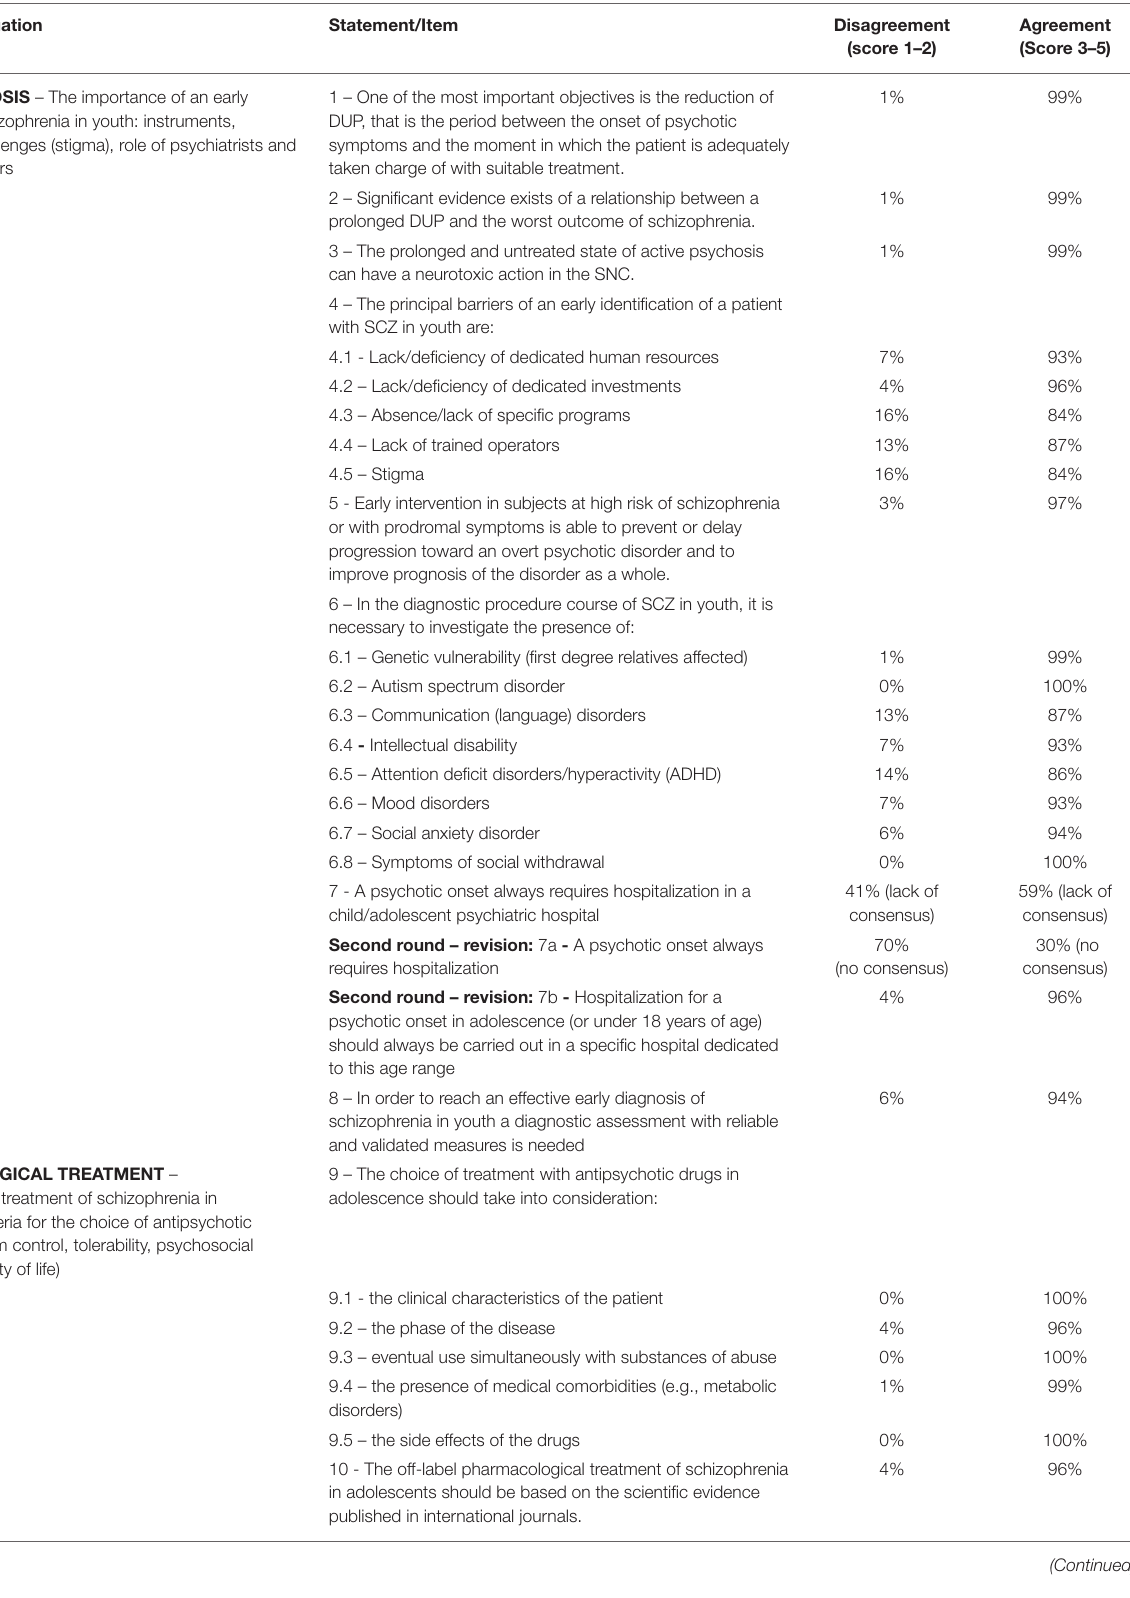
TABLE 2.1 | List of consensus statements and Delphi survey